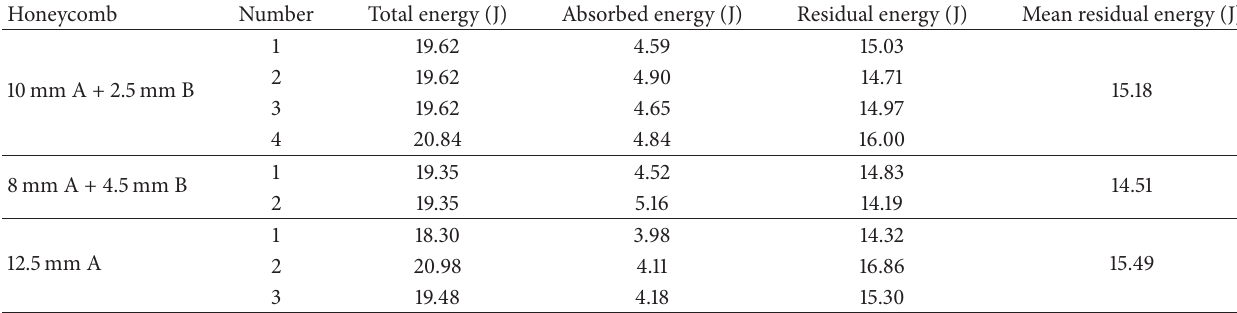
Table 6: Absorbed energy of different honeycomb buffers.